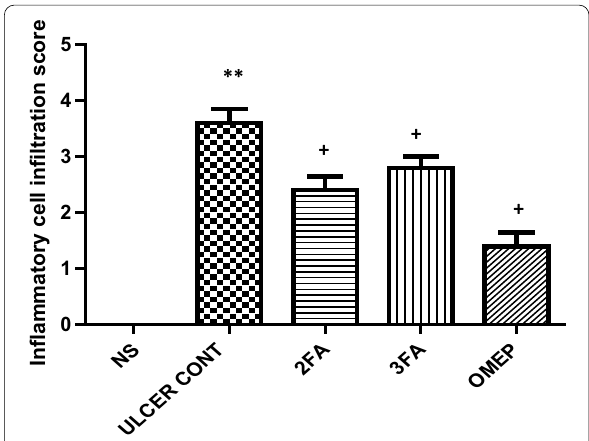
Fig. 4 Inflammatory cells infiltration in the stomach of rats treated with varying doses of folic acid and Omeprazole after pyloric ligation ulcer. (** p < 0.001 ulcer control cf. control; + p < 0.05 cf. ulcer control). NEUT COUNT, Neutrophil Count. NS